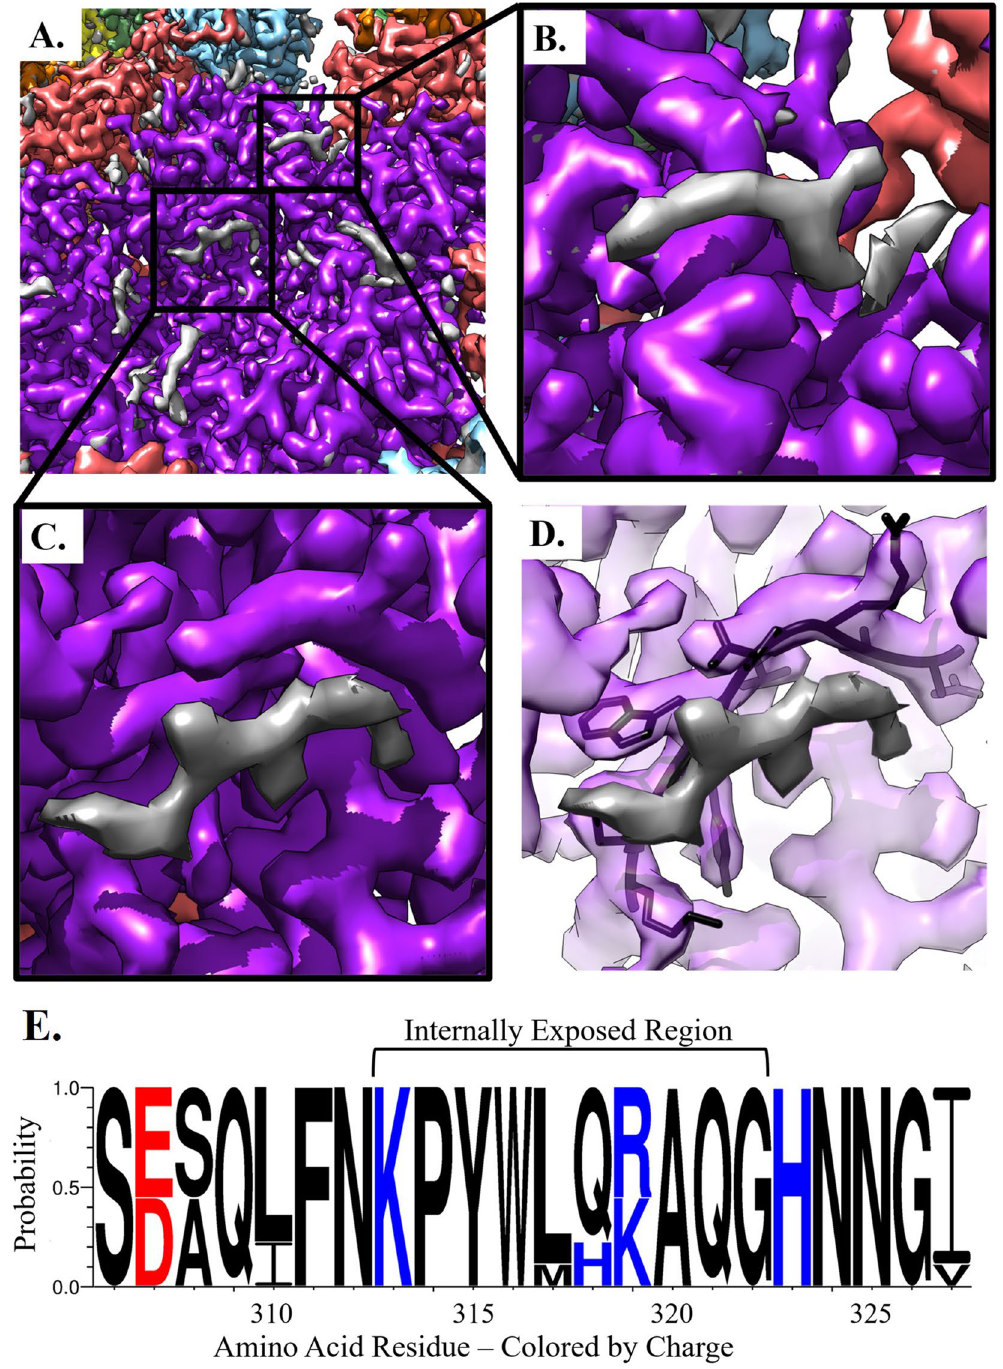
Figure 4. Non-L1 Internal Density. The capsomer density maps are colored within 2 Å of the L1 protein chain and the gray areas are putative L2 density. ( A ) The internal capsomer core of pentavalent capsomer at contour level 2. The gray density is appears as protein-like density with two distinct areas correlated to each chain of L1 in the capsomer. ( B ) Zoom in of the fishhook putative L2 density. ( C ) Zoom in of internal capsomer density. ( D ) Same view as C. with L1 transparent, the residues that are being shown make up the conserved 306-loop, that is seen flanking the area of putative L2 density. ( E ) The plot shows the protein sequence conservation of the loop region Ser306—Ile328. Colored by charge with red being acidic, and blue being basic. The internally exposed region is denoted by a bracket and is found on the interior of the capsomer and adjacent to non-L1 associated